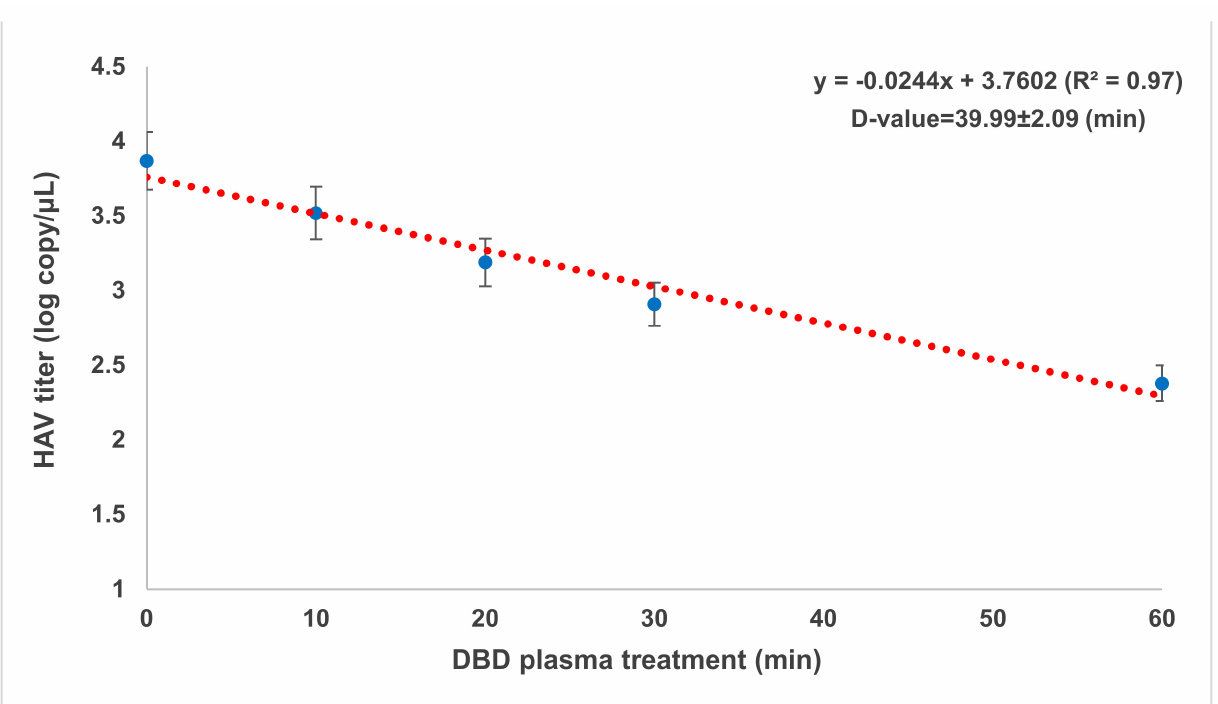
Figure 2. Fitted survival curves of HAV in PBS suspension treated by DBDP using the first-order ki- netics model. Error bars indicate the standard deviations for the mean of three samples per